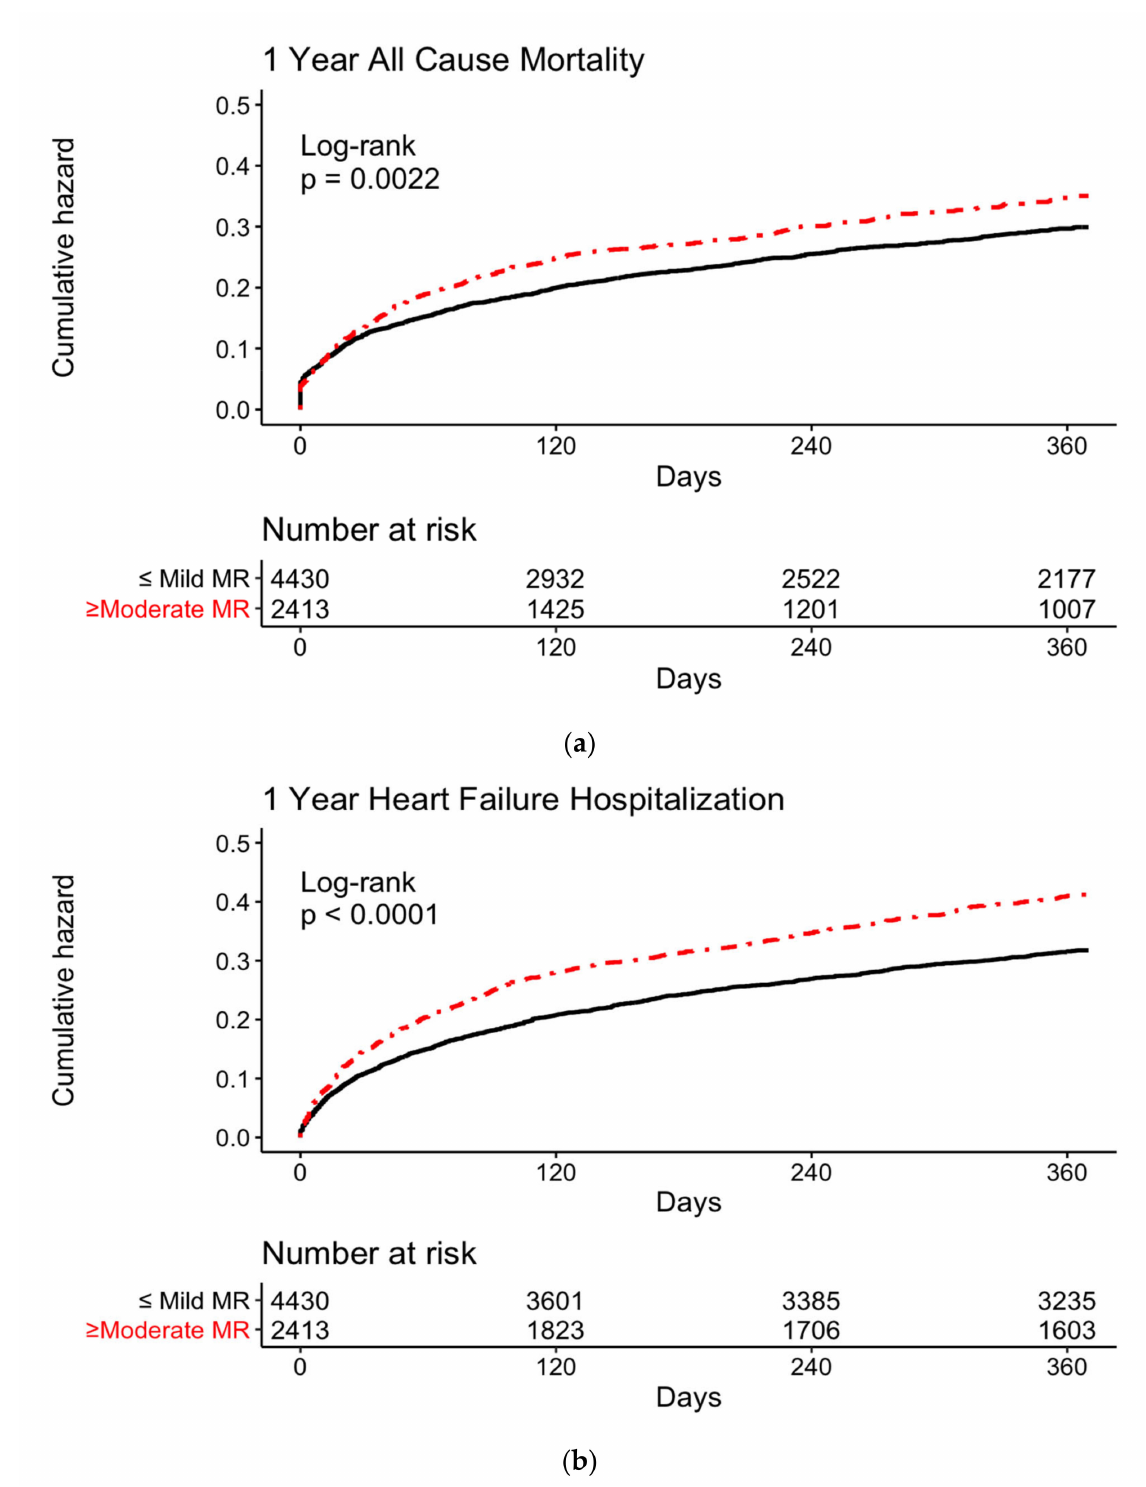
Figure 2. Kaplan–Meier curves for ( a ) 1-year all-cause mortality according to MR severity and ( b ) 1-year recurrent hospitalization according to MR